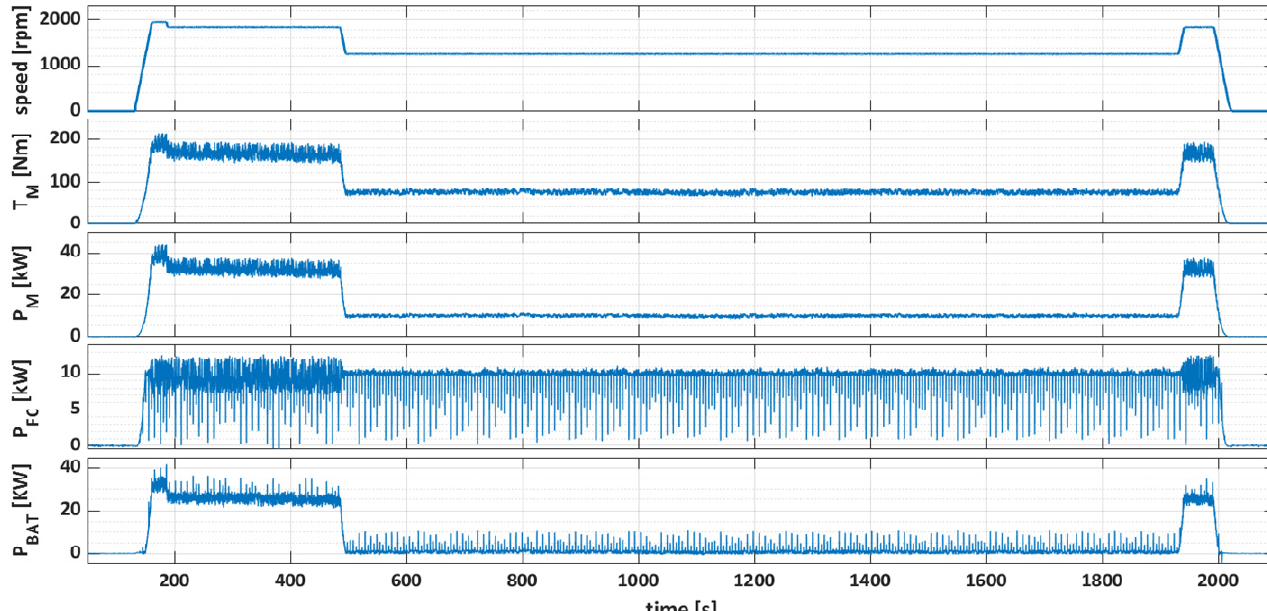
Figure 11. Selected waveforms from the stationary condition tests during realization mission profile registered by DSP controllers.